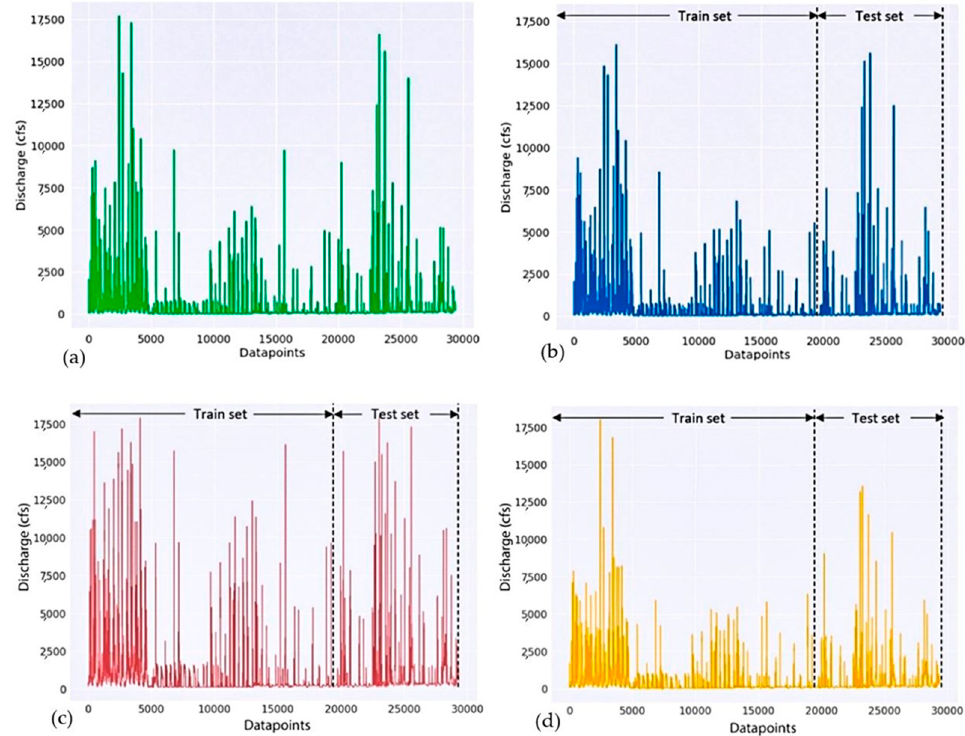
Figure 8. Distribution of observed ( a ), predicted discharge values from LSTM with RMSE 151.52 ft 3 /s ( b ), CNN with 235.74 RMSE ft 3 /s ( c ), and MLP with RMSE 489.07 ft 3 /s ( d ) for the entire discharge time series used in this study.